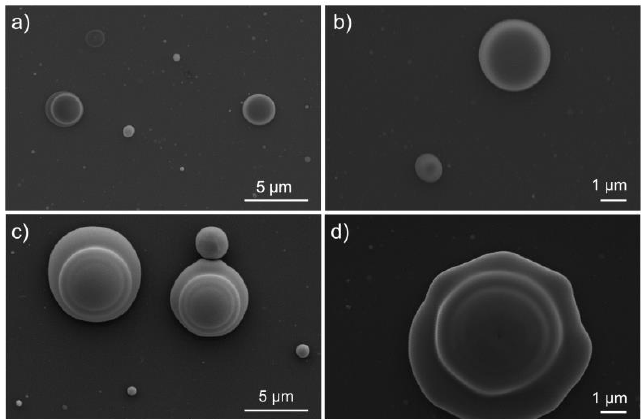
Figure 2. Fe microspheres on Si(100) generated by infrared pulsed laser ablation at deposition time of ( a , b ) 35 min (21,000 pulses); ( c , d ) 75 min (45,000 pulses). The surface features of Fe grains